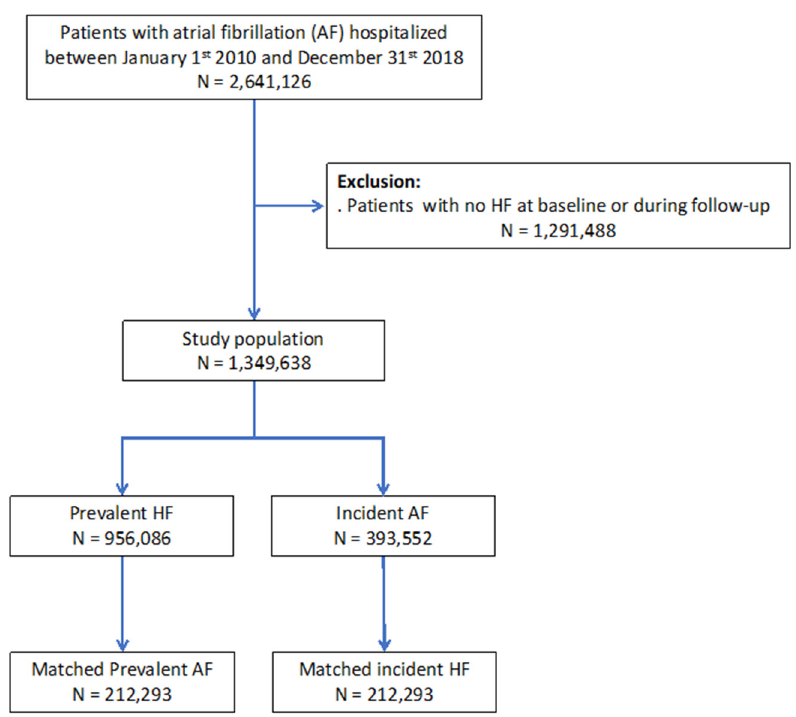
Figure 1. Flowchart of the study population and analyses.